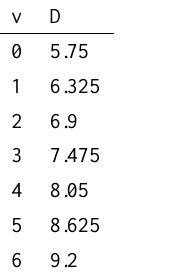
Table 1: Limit of fire spread (m) for wind speed (m/s) 𝑣 = 0 through 6